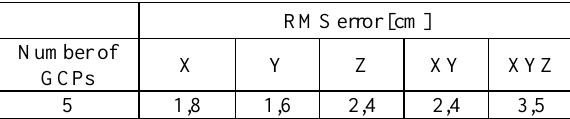
Table 6 . RMS error for GCPs referred to the photogrammetric survey of the aft part of the wreck.